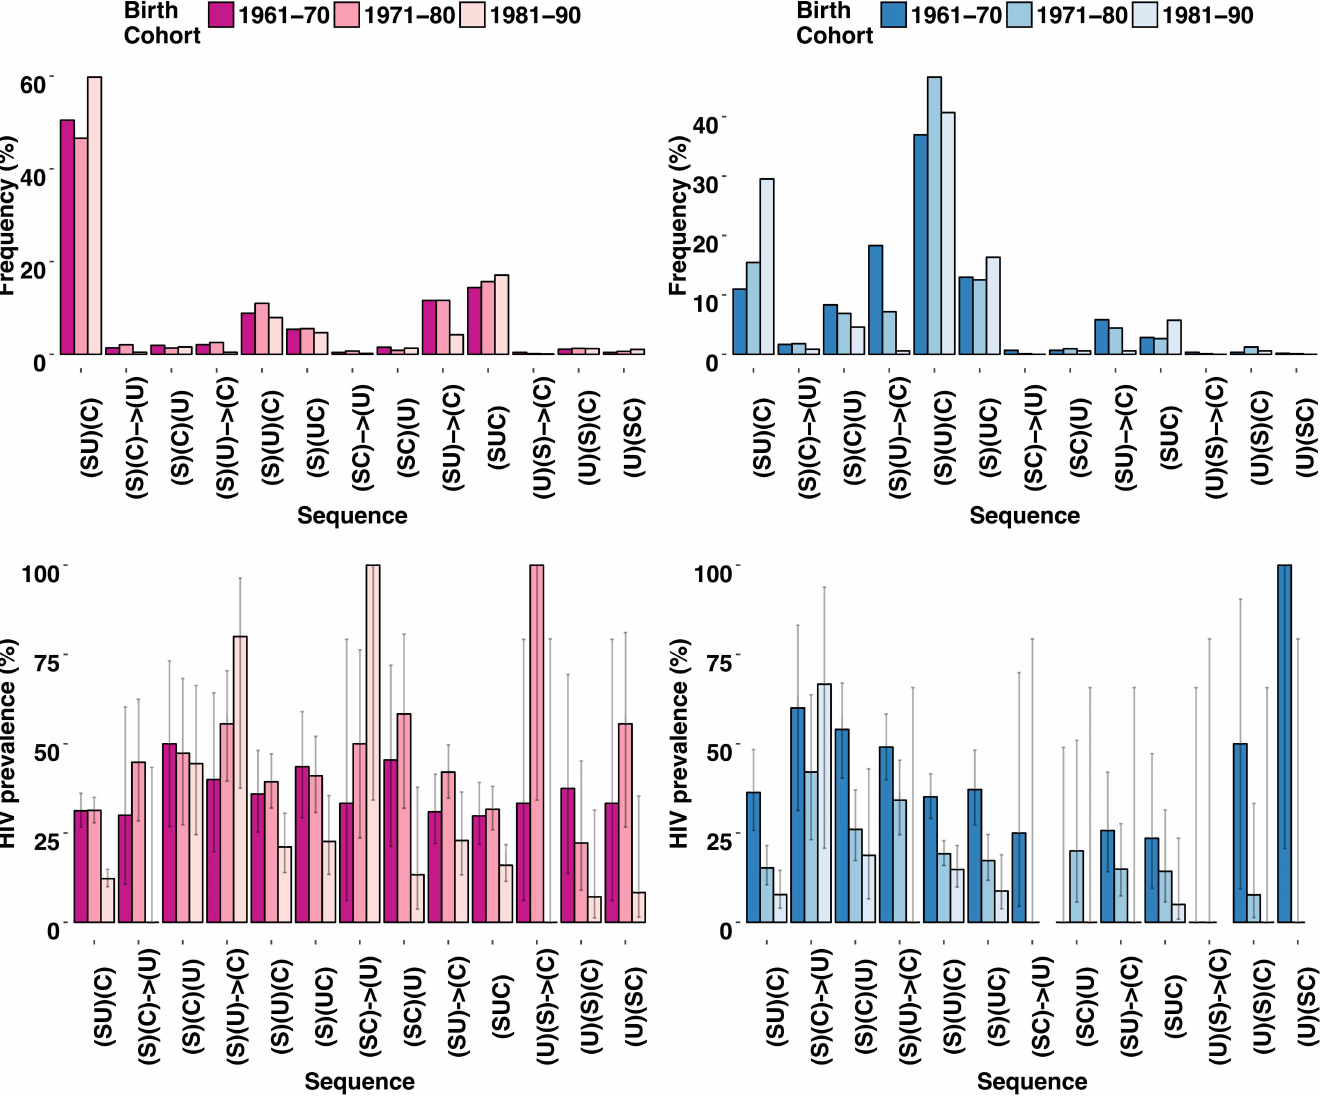
Fig 3. Relationship between sequences and HIV across birth cohorts. Change in the distributionacross birth cohorts of the sequencesand of their HIV prevalence,Manicaland(Zimbabwe), 2000–2011. Top row: bar plot of the distribution of sequencesacross birth cohorts, for women (left panel) and for men (right panel). Bottom row: bar plot (with 95% confidence interval) of the HIV prevalence associated with each sequenceacross birth cohorts, for women (left panel) and for men (right panel).